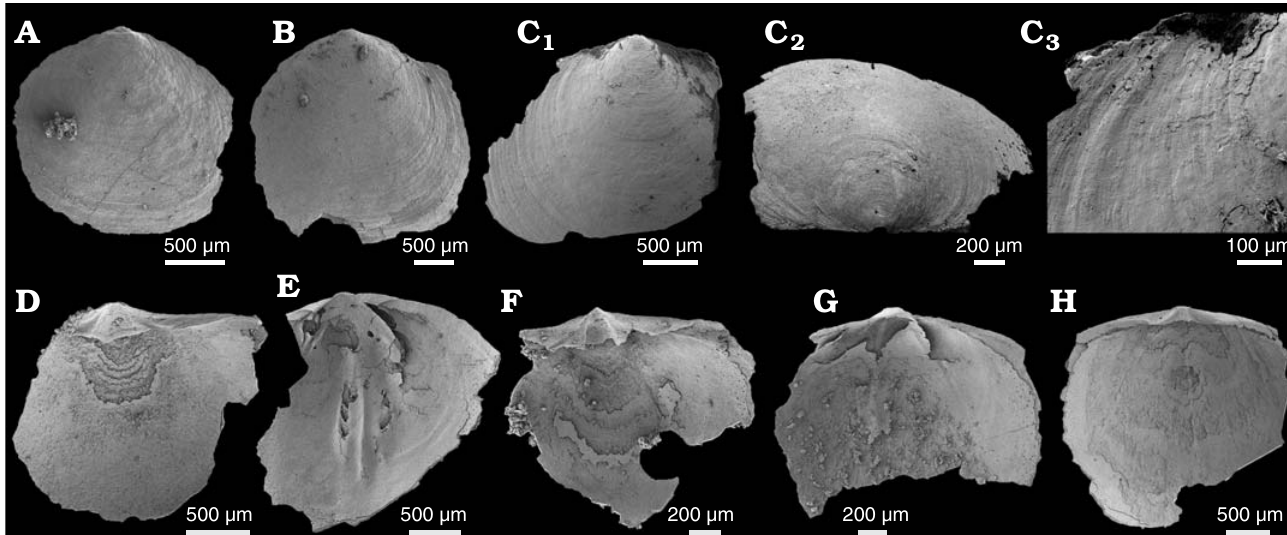
Fig. 8. The lingulid brachiopod Curdus pararaensis Holmer and Ushatinskaya in Gravestock et al., 2001 from the lower Cambrian White Point Conglomerate, Kangaroo Island, South Australia. Dorsal (A, B, E, G, H) and ventral (C, D, F) valves. A . SAM P57262 in external view. B . SAM P57263 in external view. C . SAM P57264 in external (C 1 ) and oblique (posterior) (C 2 ) views; C 3 shows external ornament of faint concentric growth lines. D . SAM P57265 in internal view. E . SAM P57266 in internal view. F . SAM P57267 in internal view. G . SAM P57268 in internal view. H . SAM P57269 in internal